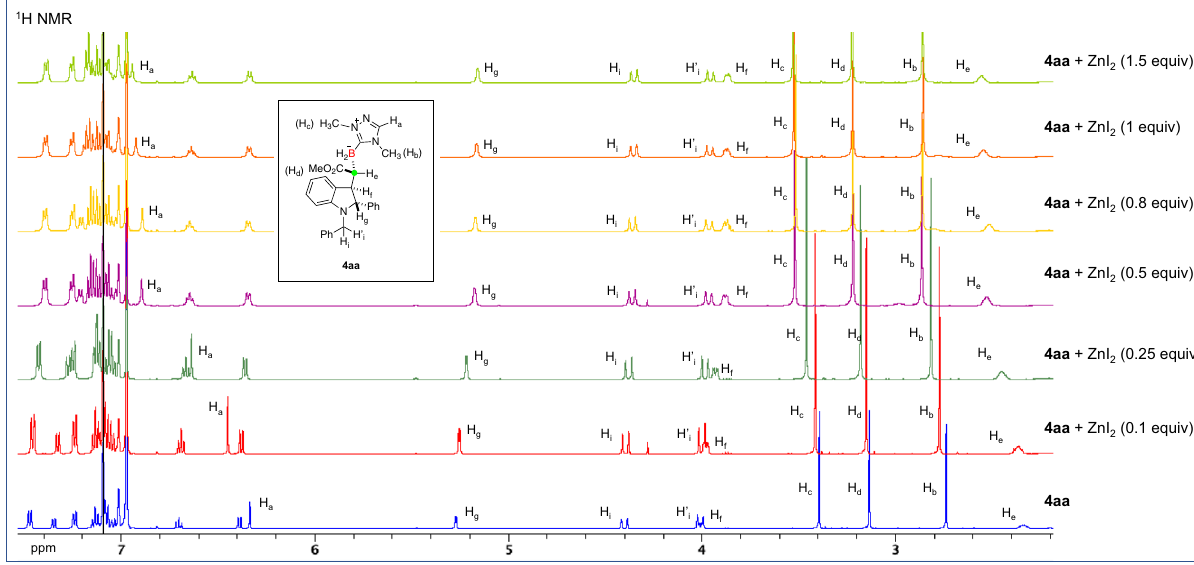
Fig. 6 Stacked 1 H NMR spectra of 4aa with an increasing amount of ZnI 2 . NMR spectra were recorded on a Bruker Avance 500 spectrometers (500 MHz) in toluene- d 8